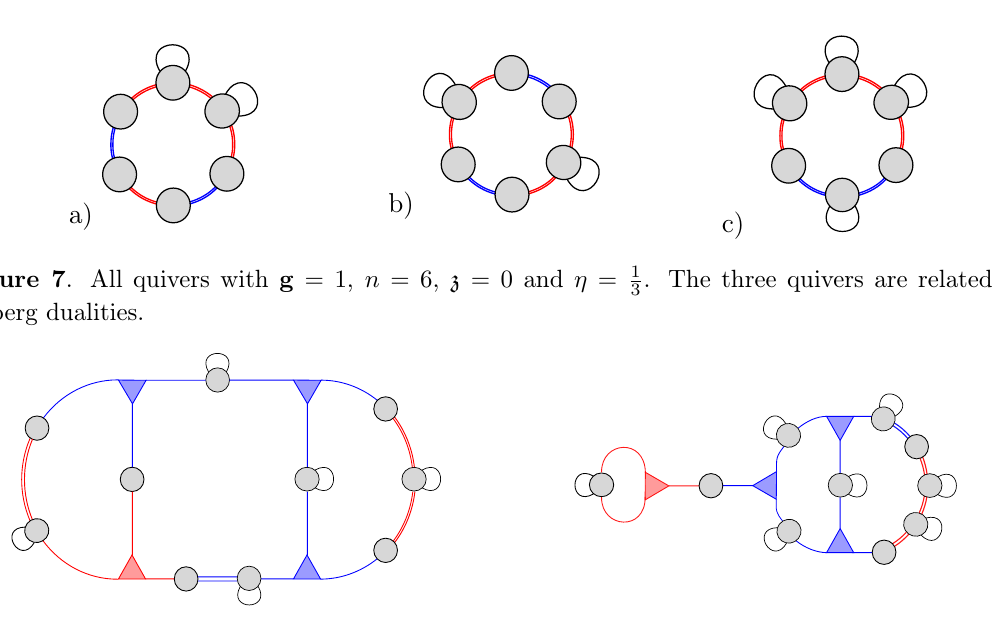
Figure 8 . An example of two different quivers which describe the same IR SCFT. The parameters specifying the quiver are g = 3 , z = 1